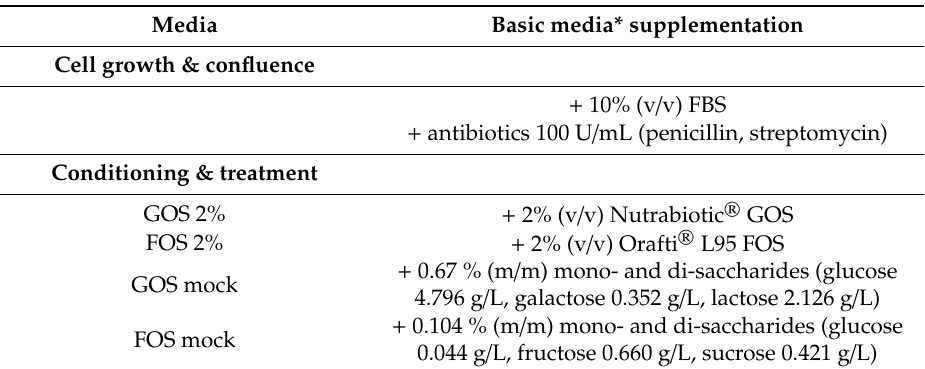
Table 2. Culture media